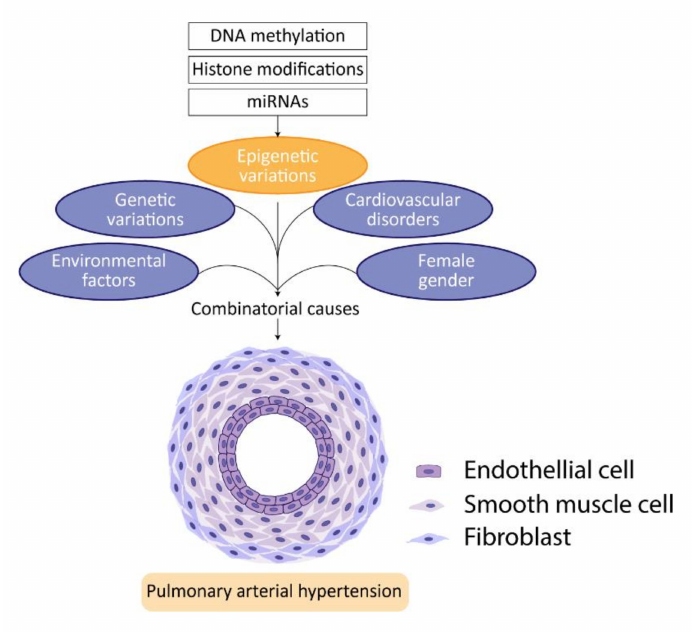
Figure 5. Epigenetics in PAH. In addition to genetic variations and other risk factors, such as gender, comorbidities, and environmental factors, epigenetic variations in PAH gain interest. Differences in DNA methylation profiles, increased histone acetylation and dysregulated miRNA expression in PAH patients point out a growing field in PAH research that provides better understanding of disease